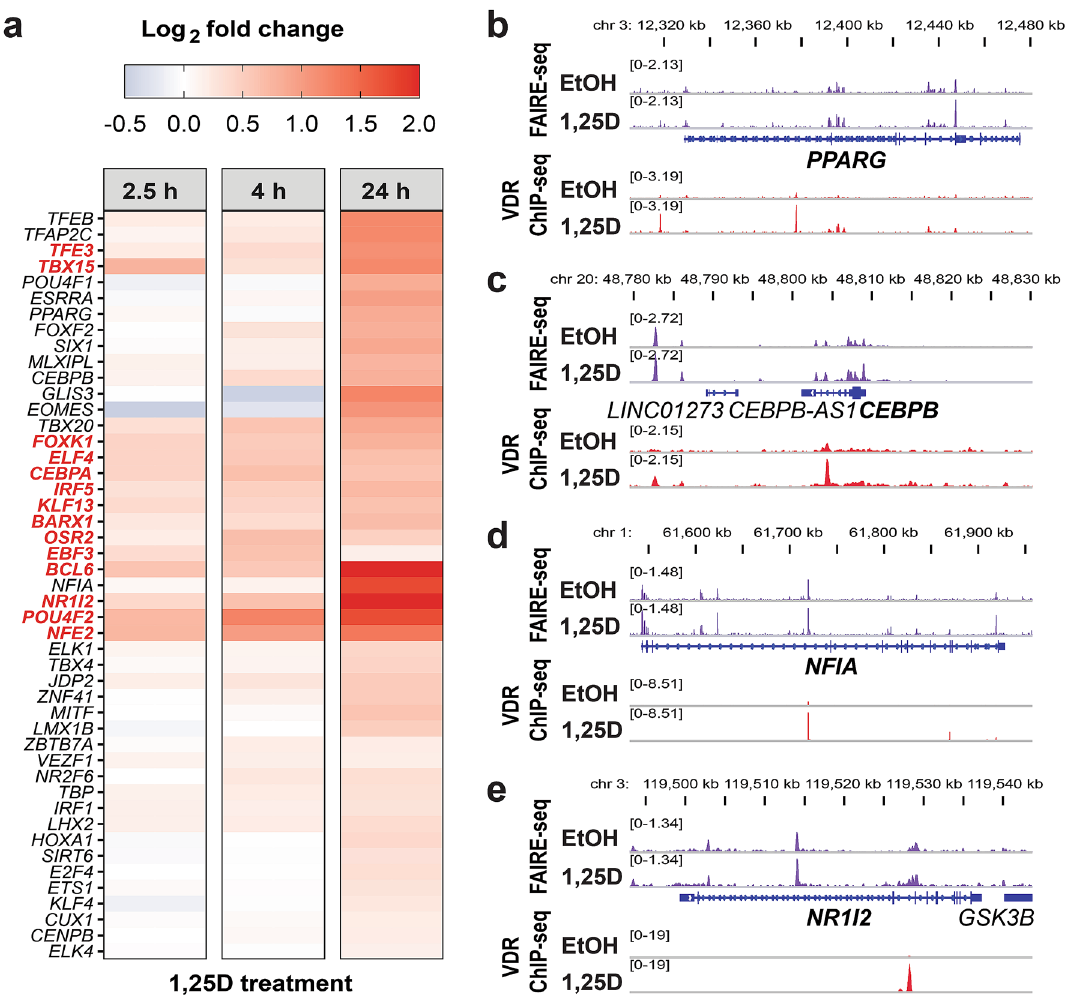
Figure 3. Identification of transcription factors that mediate secondary vitamin D responses. Log2 fold changes in gene expression versus time-matched control samples are displayed per time point for 47 genes coding for transcription factors, which have been predicted to be primary 1,25(OH) 2 D 3 targets genes ( a ). Display of VDR ChIP-seq 11 and FAIRE-seq 15 data in the IGV browser illustrates binding of VDR in regions of open chromatin in the loci of the four transcription factors PPARG , CEBPB , NFIA and NR1I2 ( b–e